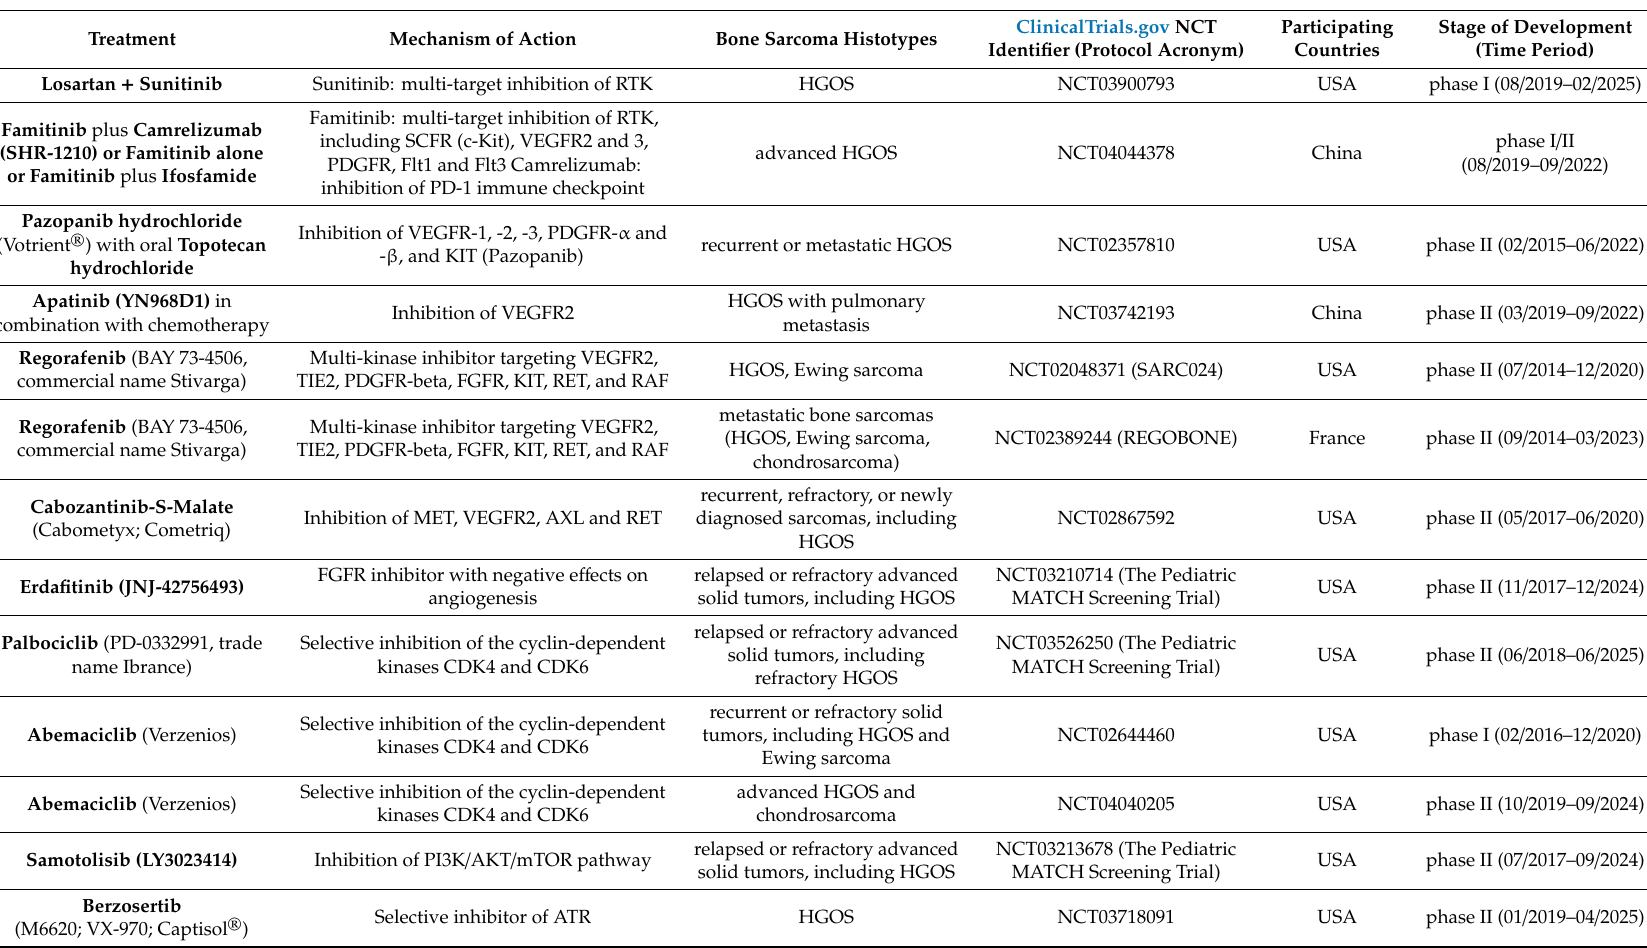
Table 1. List of target-specific clinical trials that are presently active and recruiting high-grade osteosarcoma (HGOS) patients. Time period refers to the actual study start date and estimated study completion